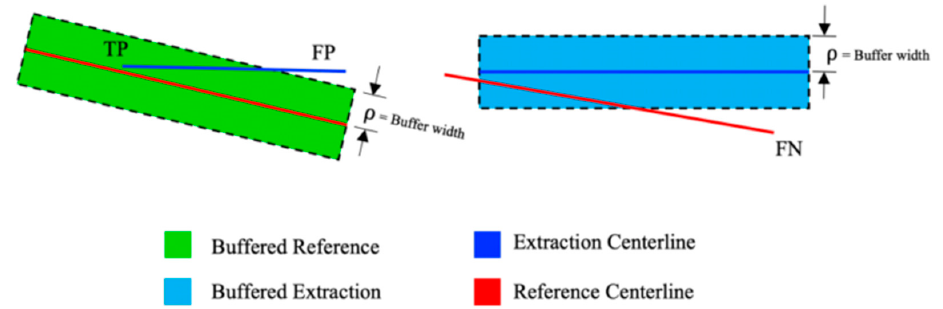
Figure 7. Road centerline extraction using the buffer method